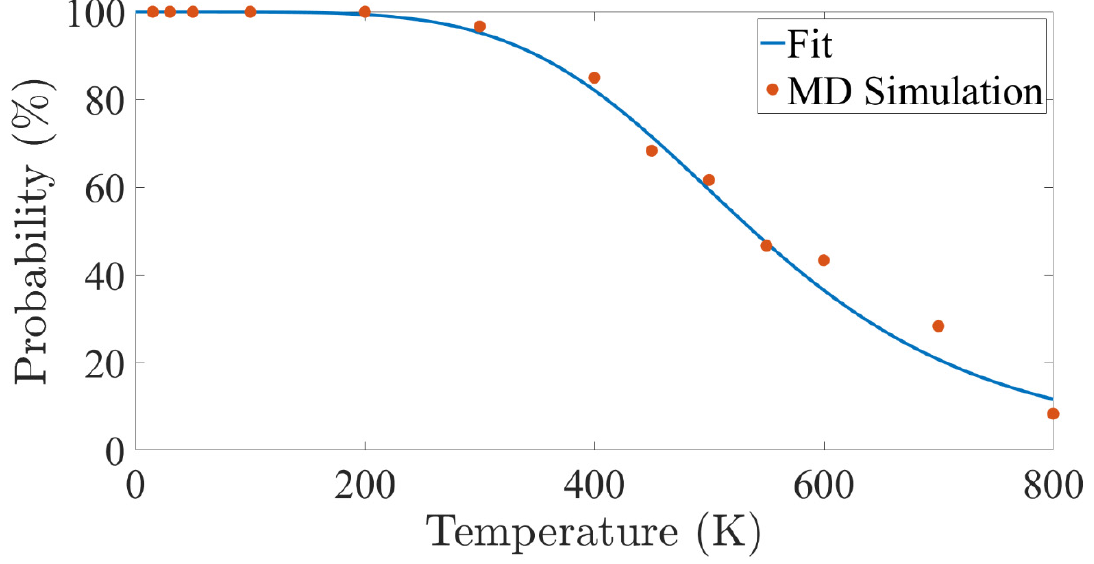
Figure 3. The probability to nucleate a dislocation at the acute angle is based on the MD simulations. A phenomenological function was fitted to the results. A phenomenological function was fitted to the